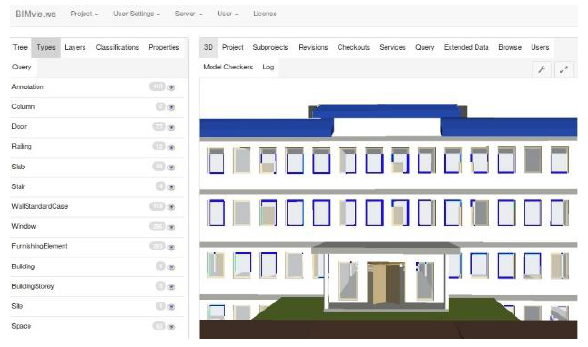
Figure 7. BIMserver: IFC on